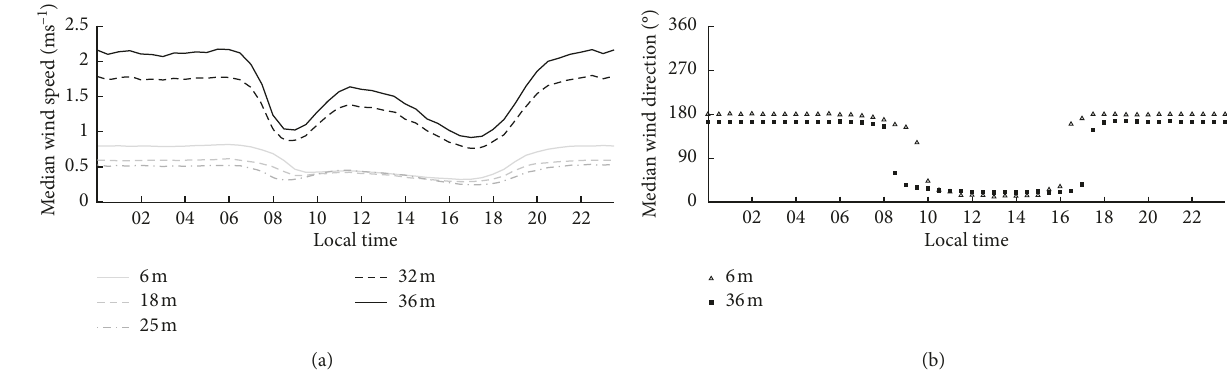
Figure 3: Median wind speed and median wind direction at different